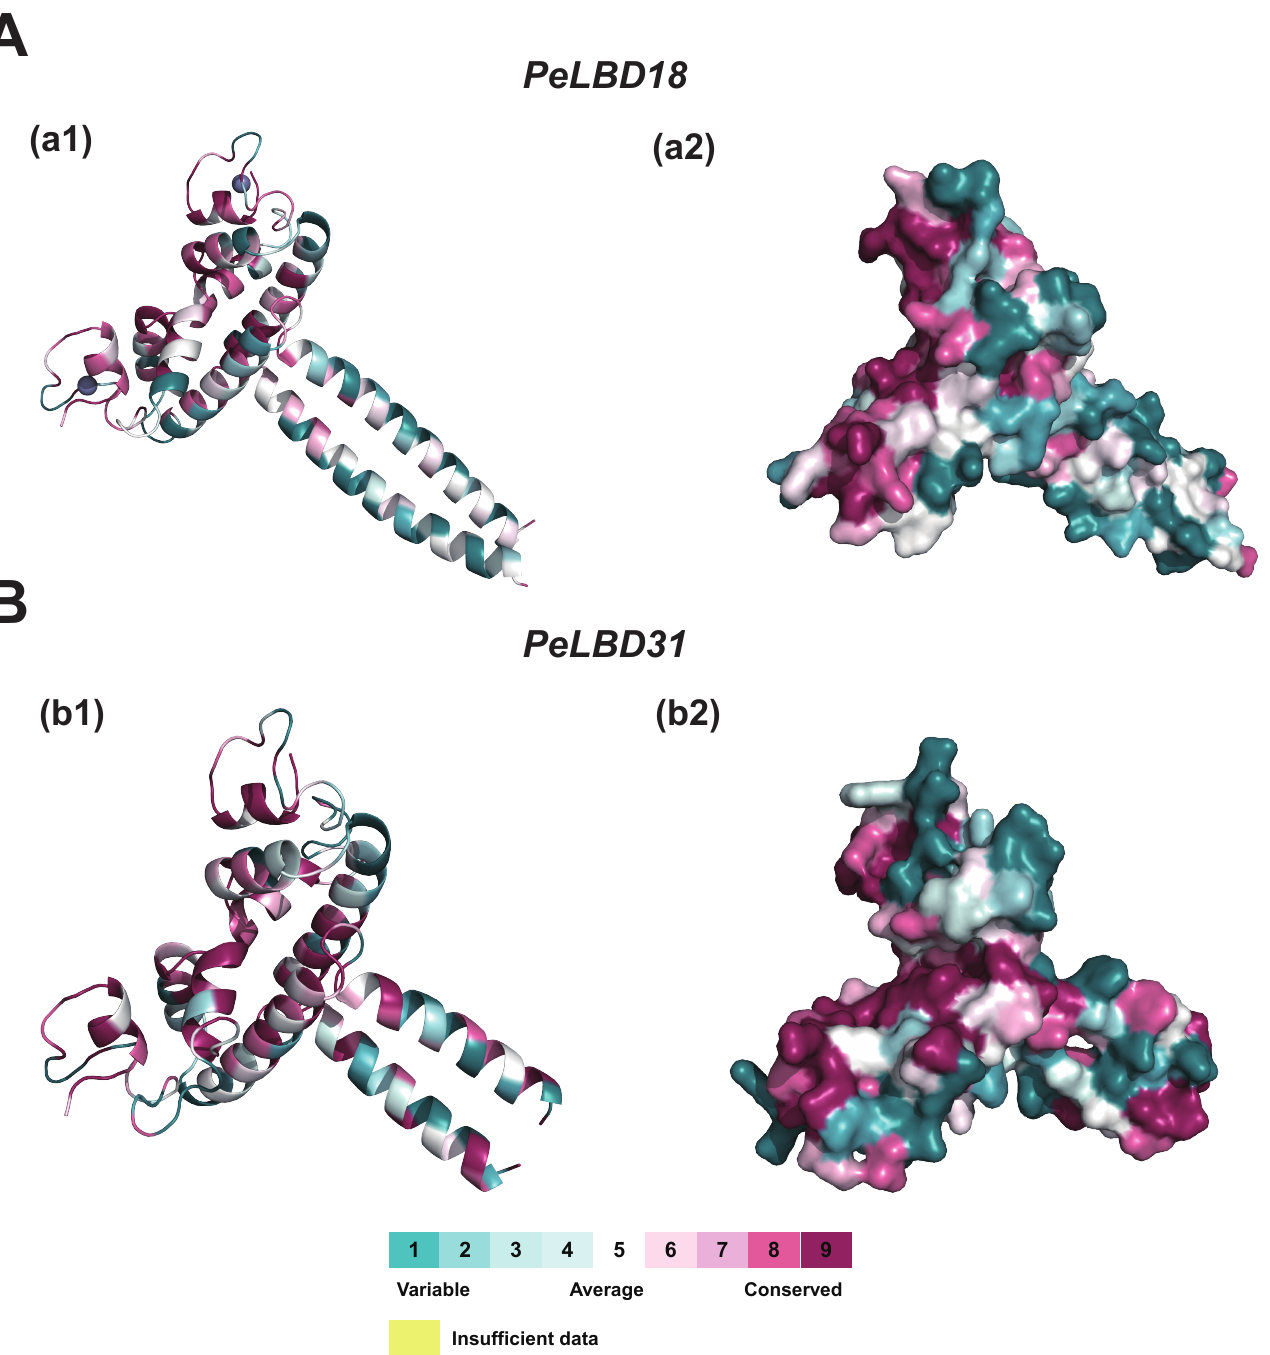
Figure 7. Predicted three-dimensional structures of the passion fruit LBD protein sequences. Display type: Cartoon ( a1 , b1 ); Surface ( a2 , b2 ). ( A ) PeLBD18 represents the structure of the Class I subfamily; ( B ) PeLBD31 represents the structure of the Class II